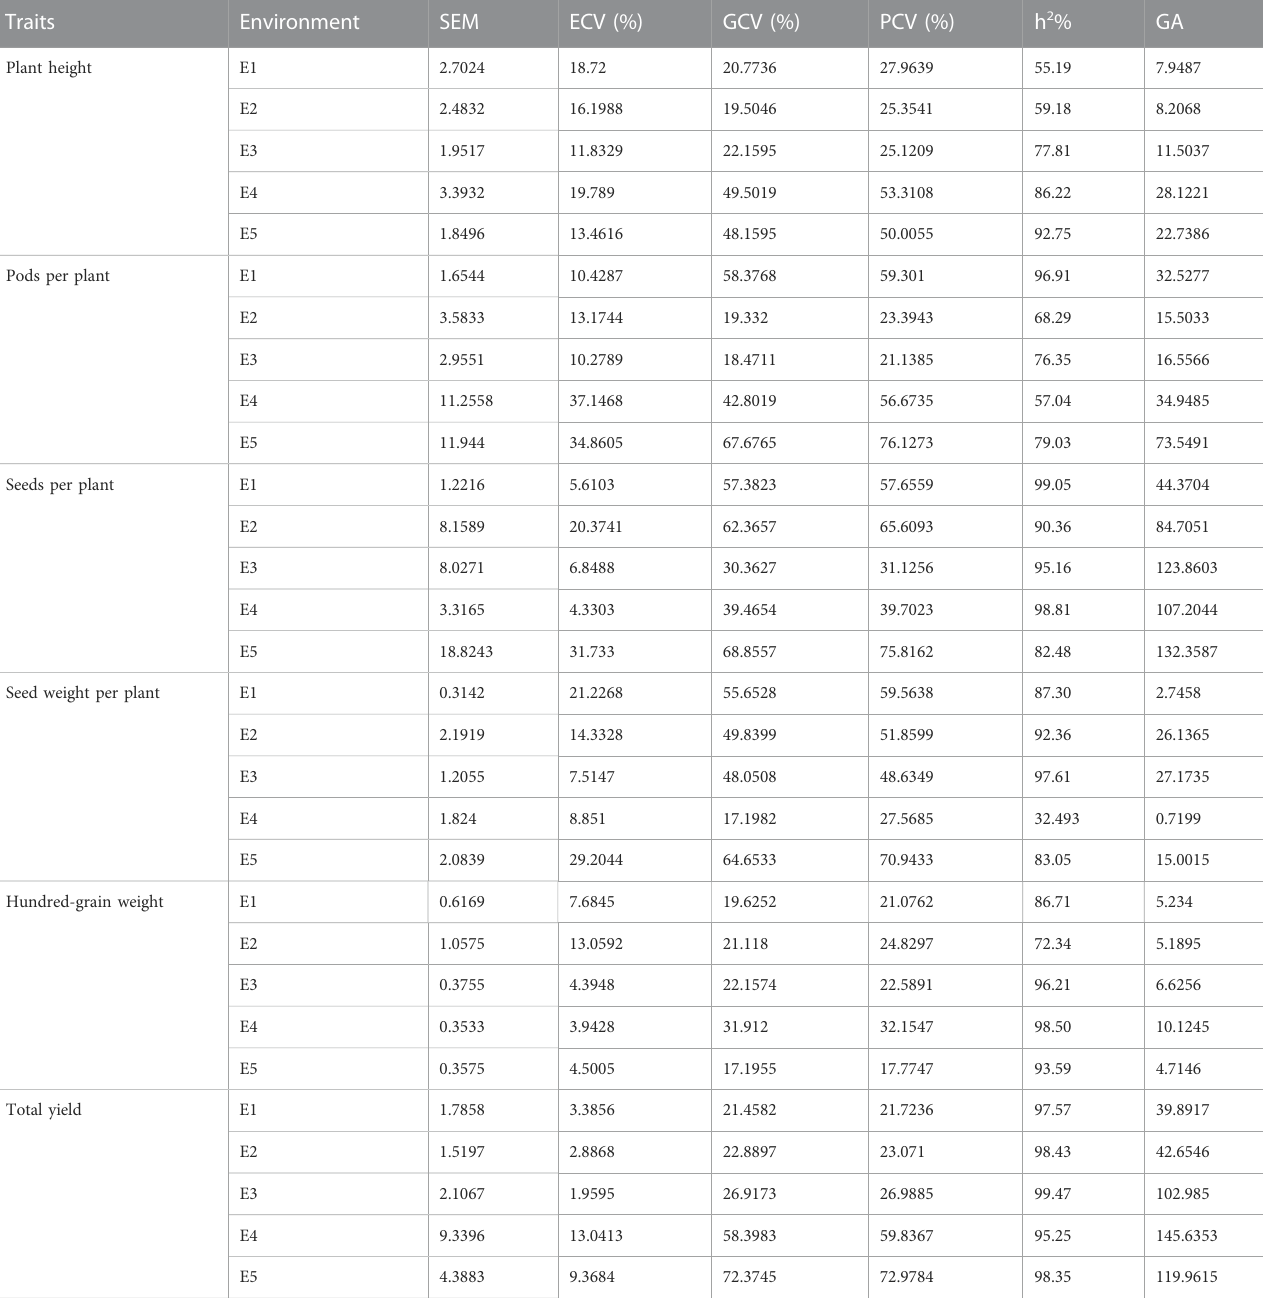
TABLE 4 Variability, heritability, and genetic advance estimate for six agronomic traits.